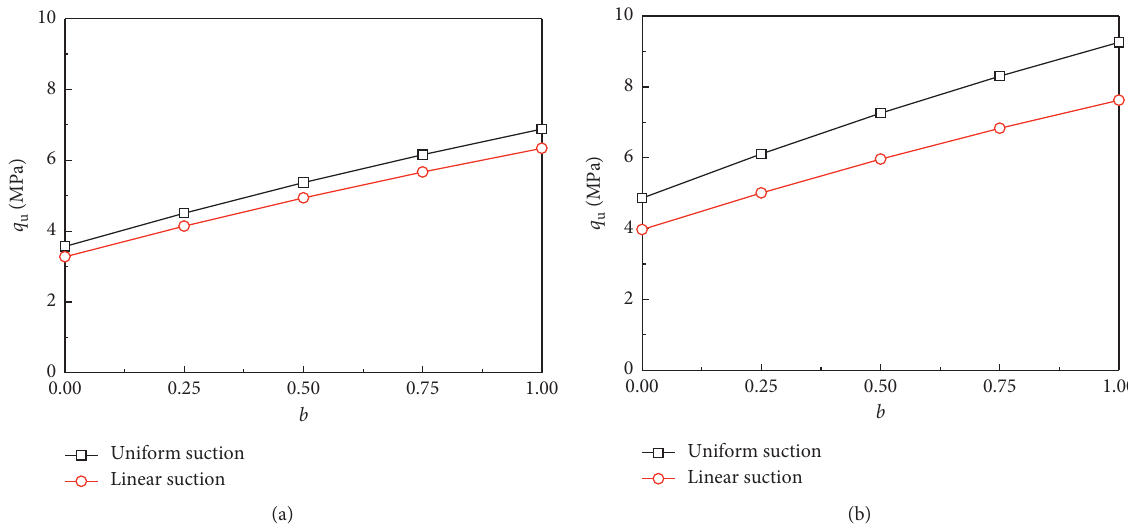
Figure 8: Effect of intermediate principal stress. (a) ( u